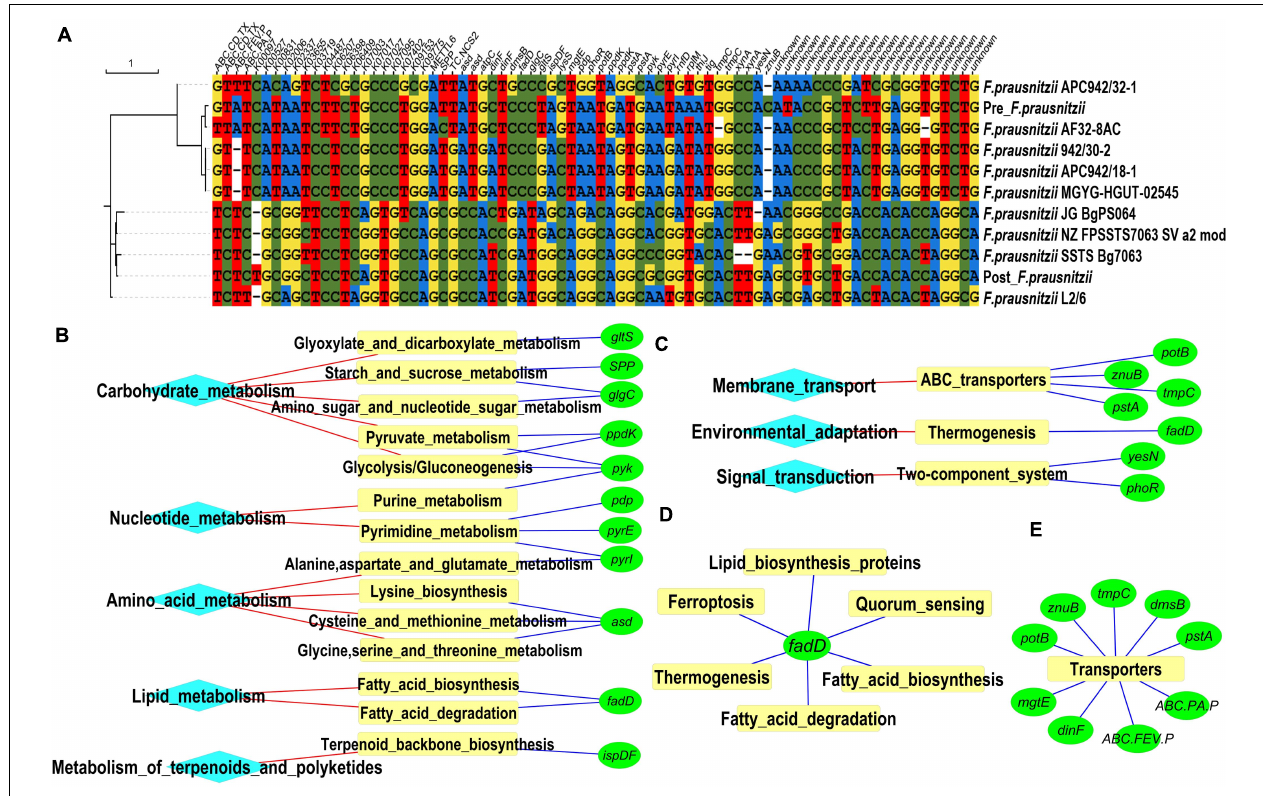
FIGURE 3 | Strains and metabolic pathways corresponding to common BiasSNPs. (A) Phylogenetic relationship of nine Faecalibacterium prausnitzii and the corresponding strains of pre- and post-intervention groups based on the common BiasSNPs. (B) Metabolic pathways related to nutrition metabolism. (C) Metabolic pathways associated with environmental adaptation. (D) Metabolic pathways associated with the gene fadD . (E) Genes encoding transporters.